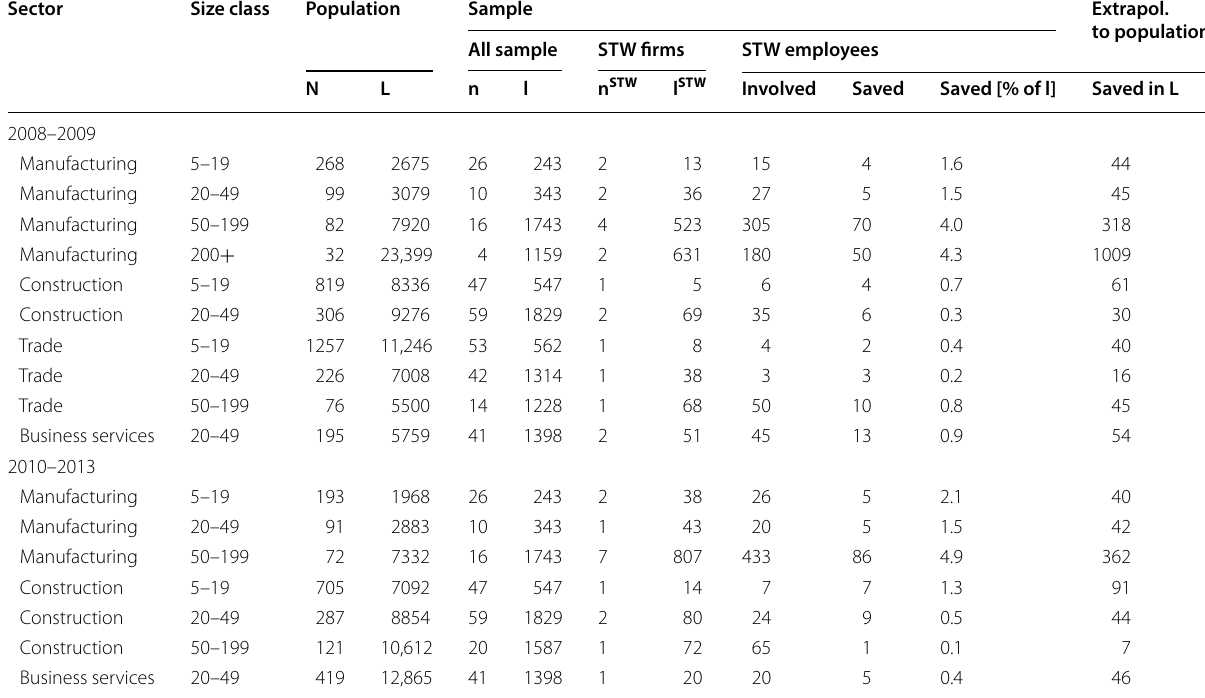
Table 5 Use of STW by